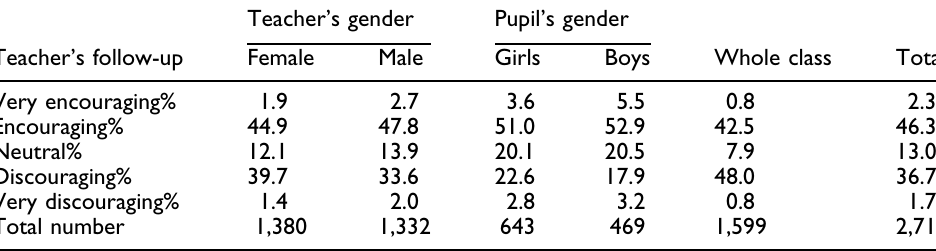
Table 6. Teacher’s follow-up move by teachers’ and pupil’s gender. Teacher’s gender Pupil’s gender Female Male Girls Boys Whole class Total Teacher’s follow-up Very